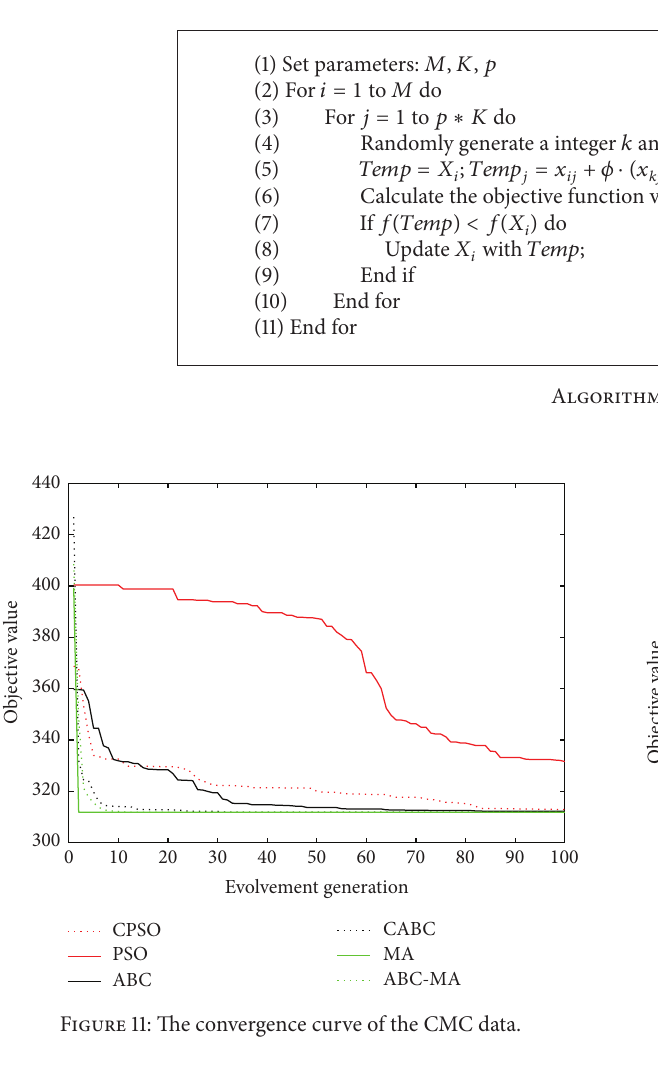
Figure 13: The convergence curve of the glass data.